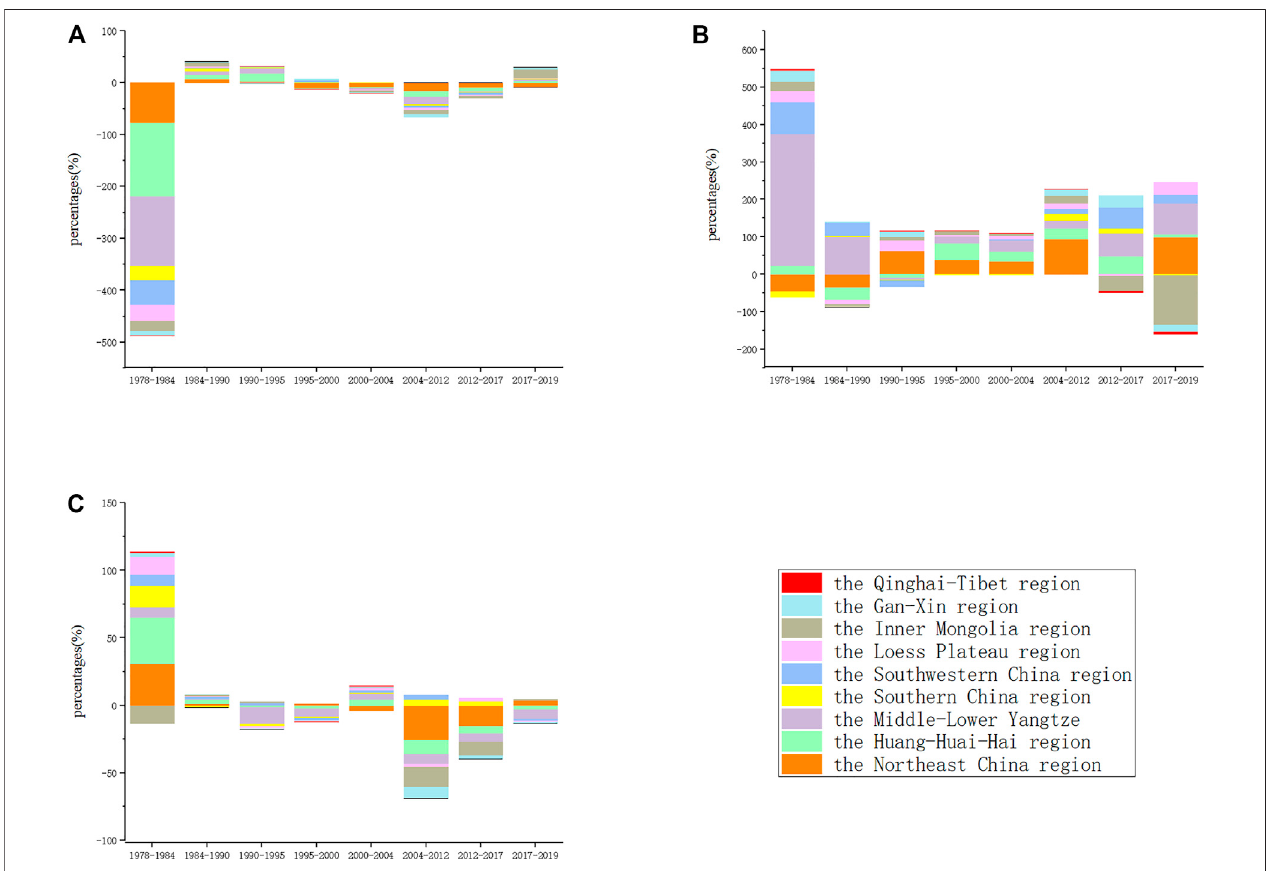
FIGURE 5 | Contributions of driving factors in nine agricultural regions of China. (A) represents the yield loss density effect, (B) represents the disaster intensity effect, and (C) is the grain planting area effect.